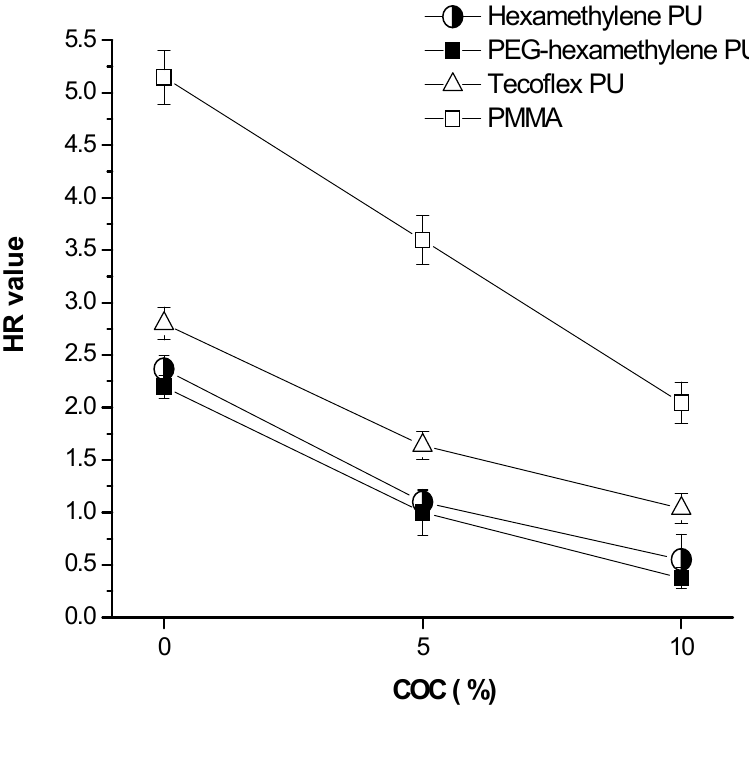
Figure 6. Effects of COC content embedded in polymer composites on hemolysis ratio (HR)